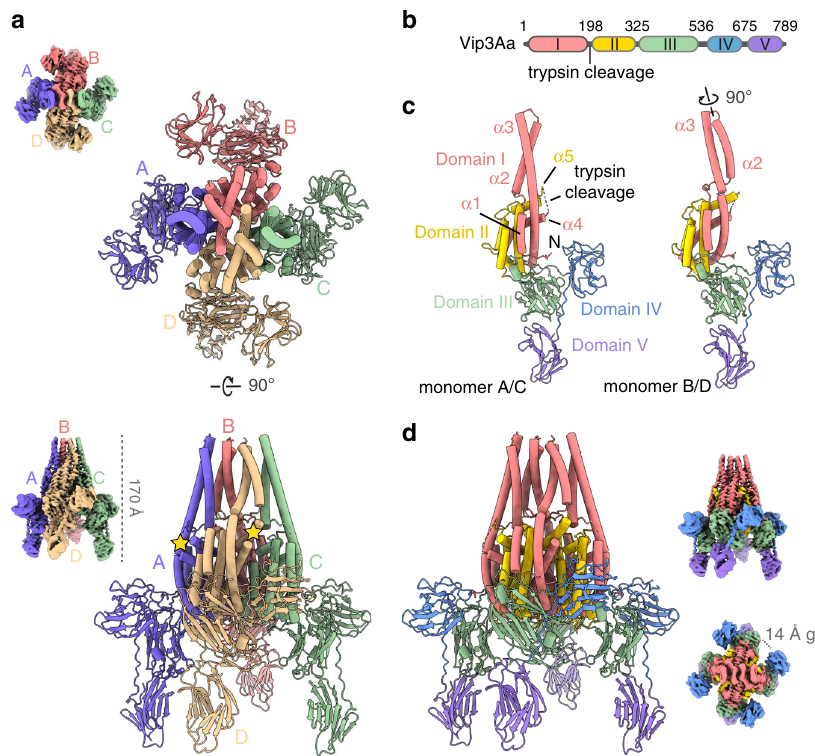
Fig. 1 Protoxin structure of Vip3Aa from Bacillus thuringiensis . a Two orthogonal views of the Vip3Aa protoxin. Each monomer has been colored differently. Yellow stars mark the position of the trypsin cleavage site in two of the monomers. Unsharpened EM map shown on the left. b Primary structure of Vip3Aa. c Vip3Aa is formed by two types of monomers, outer (left), and inner (right), that are mainly differentiated by a ~90° rotation of the α 2 – α 3 helical bundle. d Vip3Aa tetramer colored according to the domain organization. Two orthogonal views of the EM reconstruction are shown on the